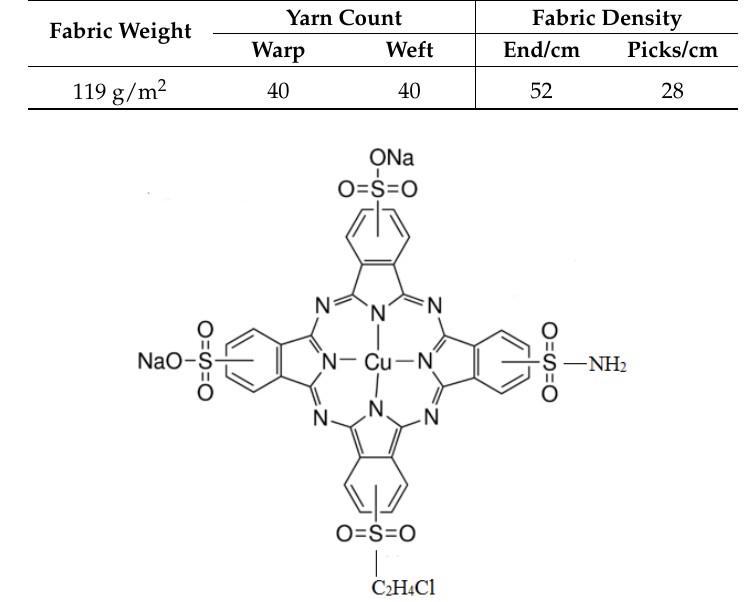
Figure 2. Chemical structure of RB ‐ 25.